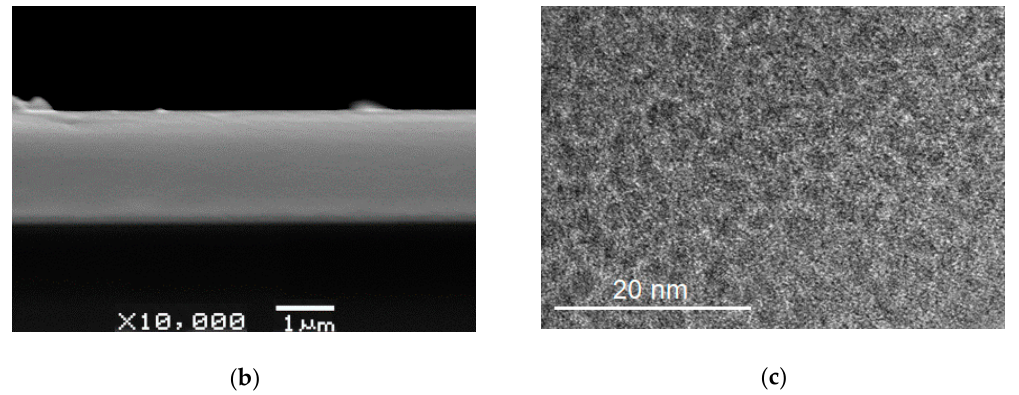
Figure 2. The structure and morphology of Zr–C coatings with carbon content in the range of 50–85 at.%: ( a ) selected X-ray diffractograms of the coatings, ( b ) SEM cross section image of coating with approx. 63 at.% of C, ( c ) HRTEM image of coating with approx. 63 at.% of C.